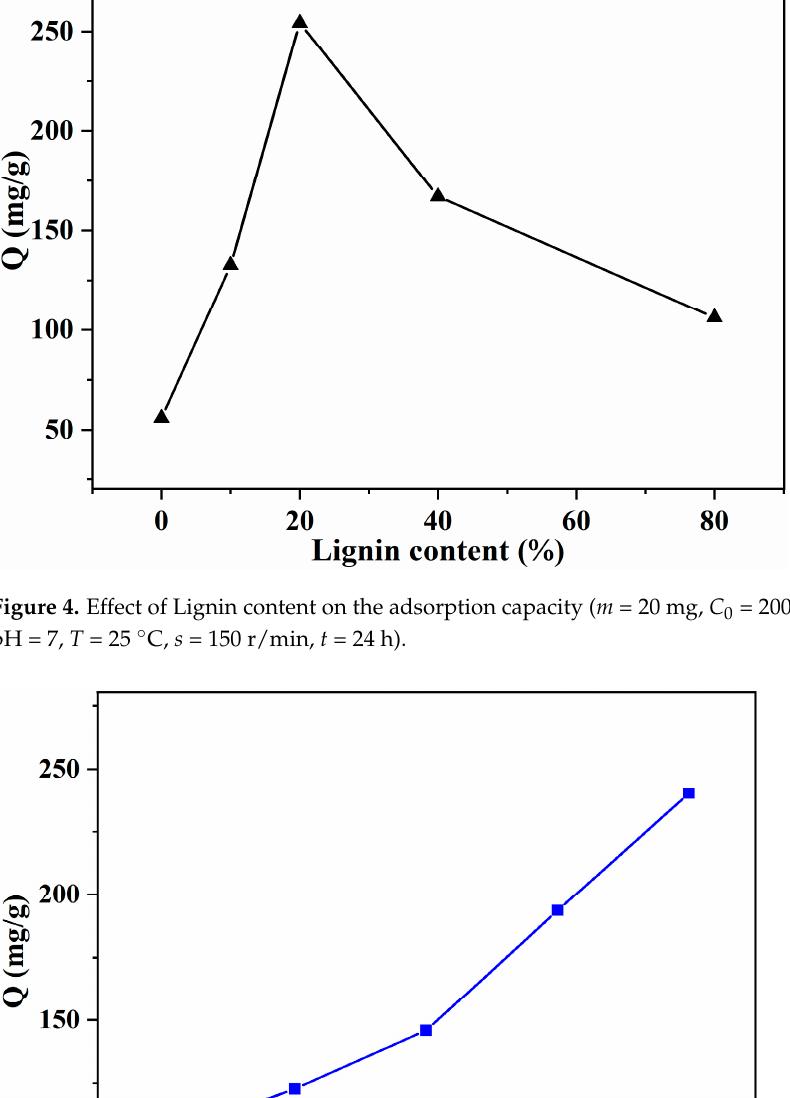
5 of 11 Figure 3. TG spectra of SA, Lig, SA/Lig-20% beads. 3.2. Removal of MB with SA/Lig Beads 3.2.1. Effect of Lignin Content The adsorption capacity of MB with different SA/Lig beads is shown in Figure 4. With the incorporation of aromatic lignin, the adsorption capacity of the composite beads clearly was enhanced. The maximum adsorption capacity (254.3 mg/g) was observed for the SA/Lig-20% adsorbent, with a removal rate of 84.8%. This is much higher than that of SA beads, which can be attributed to the formation of intermolecular interaction such as π - π stacking and a hydrogen bond between the lignin component and the MB molecules, similar to the adsorption of Congo red onto graphene oxide/chitosan pellets [23,24]. When the content of lignin exceeded 20%, the adsorption capacity decreased, which can be as-